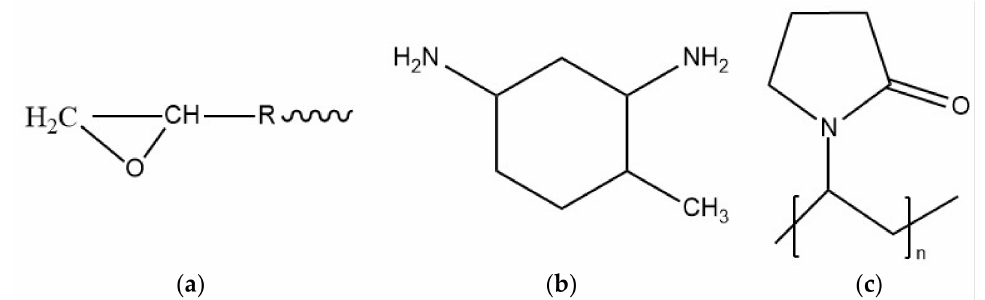
Figure 1. The chemical structures of ( a ) E51 epoxy, ( b ) HTDA, and ( c )